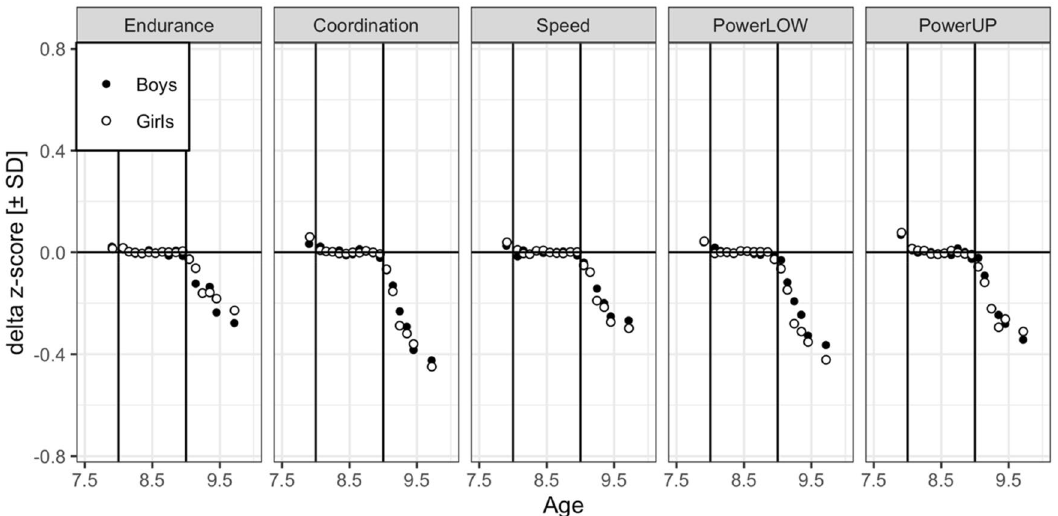
Figure 2. Delta z-score between observed and predicted physical fitness development for boys (closed circles) and girls (open circles) aged 7.00–10.0 years. Data were z-transformed. Endurance = cardiorespiratory endurance (i.e., 6-min-run test), Coordination = star-run test, Speed = 20-m linear sprint test, PowerLOW = lower limbs muscle power (i.e., standing long jump test), PowerUP = upper limbs muscle power (i.e., ball-push test). Note that delta z-scores for younger-than-keyage boys and girls were aggregated over 7.00– 7.99 years and that delta z-scores for older-than-keyage boys and girls were aggregated over 9.50–9.99 years. Points are binned delta child means. Coordination and speed times were converted from seconds to meters/ seconds (i.e., pace scores; star-run test = 50.912 [m]/time [s]; 20-m linear sprint test = 20 [m]/time [s]). These transformations have the advantage that a large value is indicative of better physical fitness and that they remove skew in the